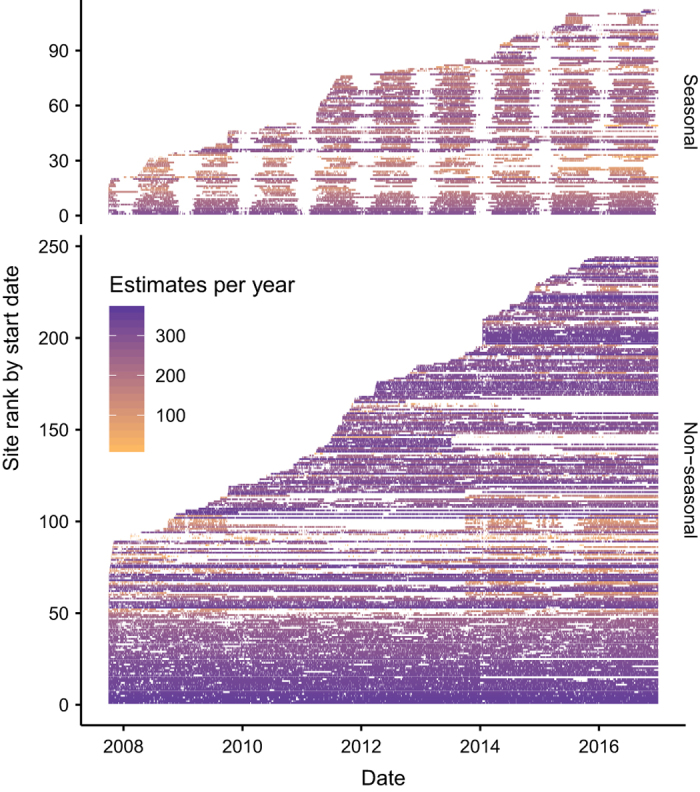
Temporal distribution of metabolism estimates at each site.Each site forms a row, and horizontal line segments represent periods of continuous daily metabolism estimates. Colors give density of estimates, ranging from 17 to 365 daily estimates per year. For the purpose of this figure, sites were considered “seasonal” if the number of metabolism estimates in January was fewer than 1/24 the total number of estimates at a site (112 of 356 sites meet this criterion).